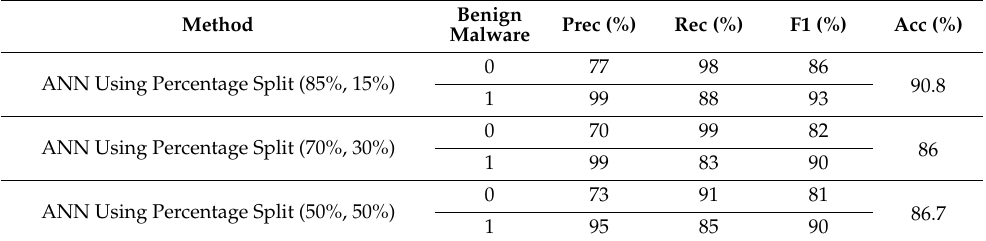
Table 6. Performance results when ANN was used.